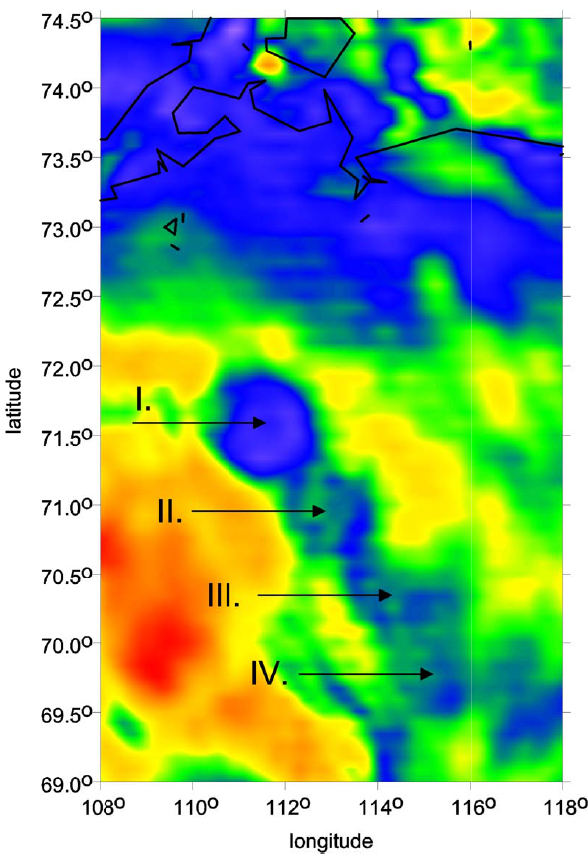
Fig. 3. Second radial derivative T rr [E] computed from the com- plete EGM2008 at Popigai (note circular-like candidates for impact craters less pronounced than the original crater but visible in the SE direction from the original